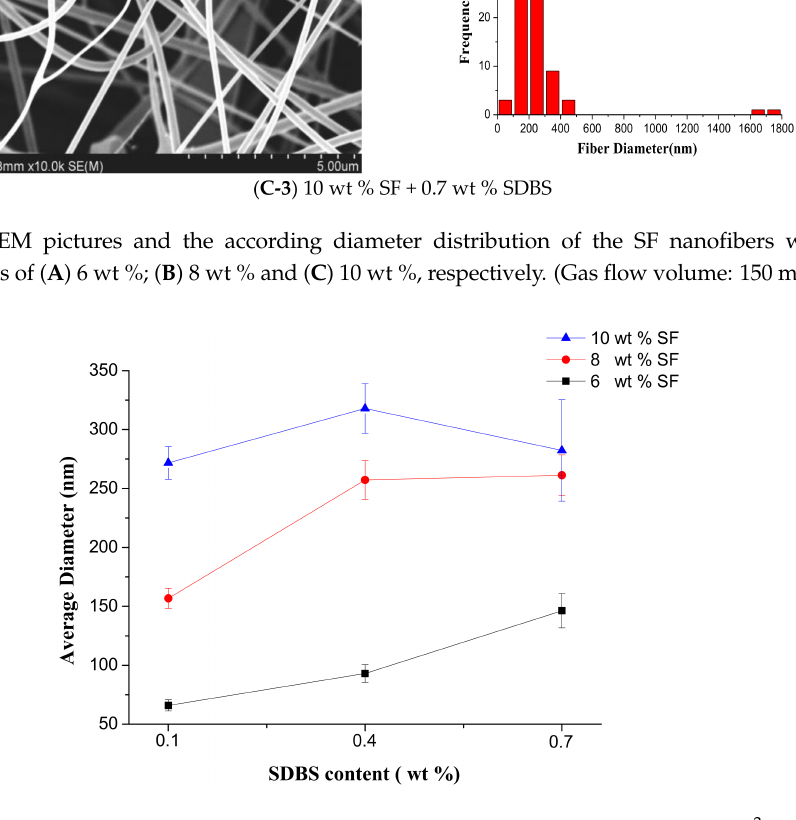
Figure 6. Average diameter of SF nanofibers when the gas flow volume was 150 m 3 /h. Table 2. Effects of SF concentration and SDBS content on the average diameter of SF nanofibers when the gas flow volume was 150 m 3